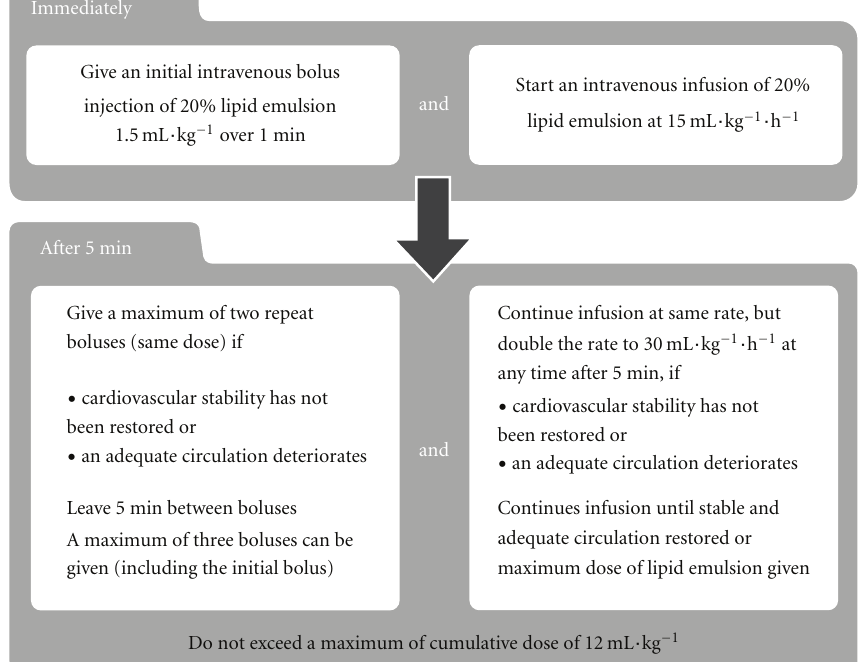
Figure 2: AAGBI local anaesthetic toxicity guideline 2010 (with permission)